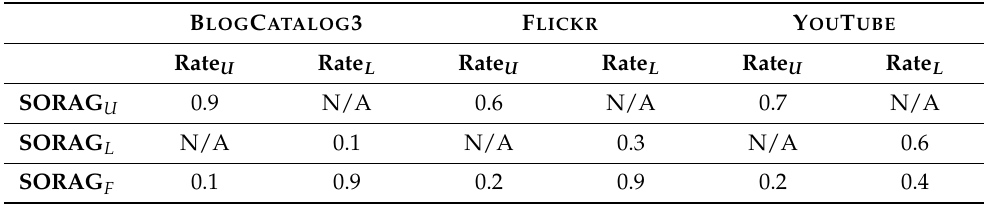
Table 4. Optimal over-sampling rates for the synthetic unlabeled nodes (denoted as Rate U ) and synthetic labeled nodes (denoted as Rate L ) on each dataset. N/A abbreviates for “not applicable”. B LOG C ATALOG 3